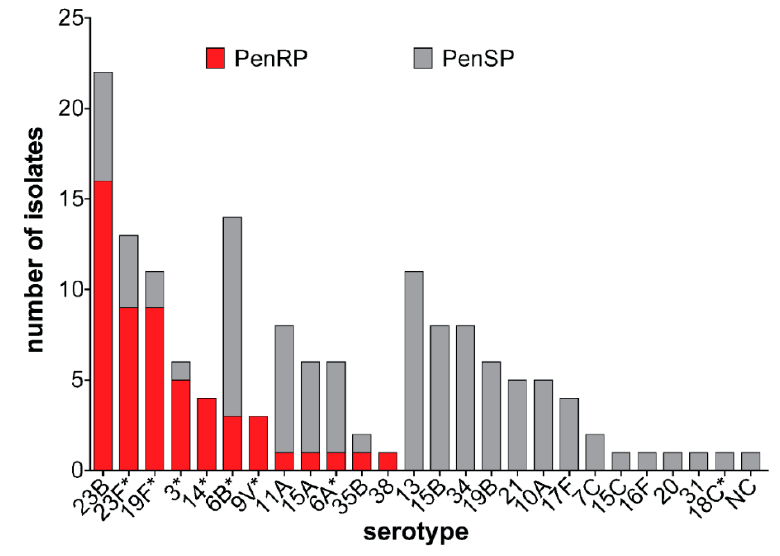
Figure 3. Penicillin susceptibility by serotype among pneumococcal strains. Serotypes were grouped into penicillin resistant pneumococci (PenRP) in red color and penicillin susceptible pneumococci (PenSP) in grey color. * PCV13